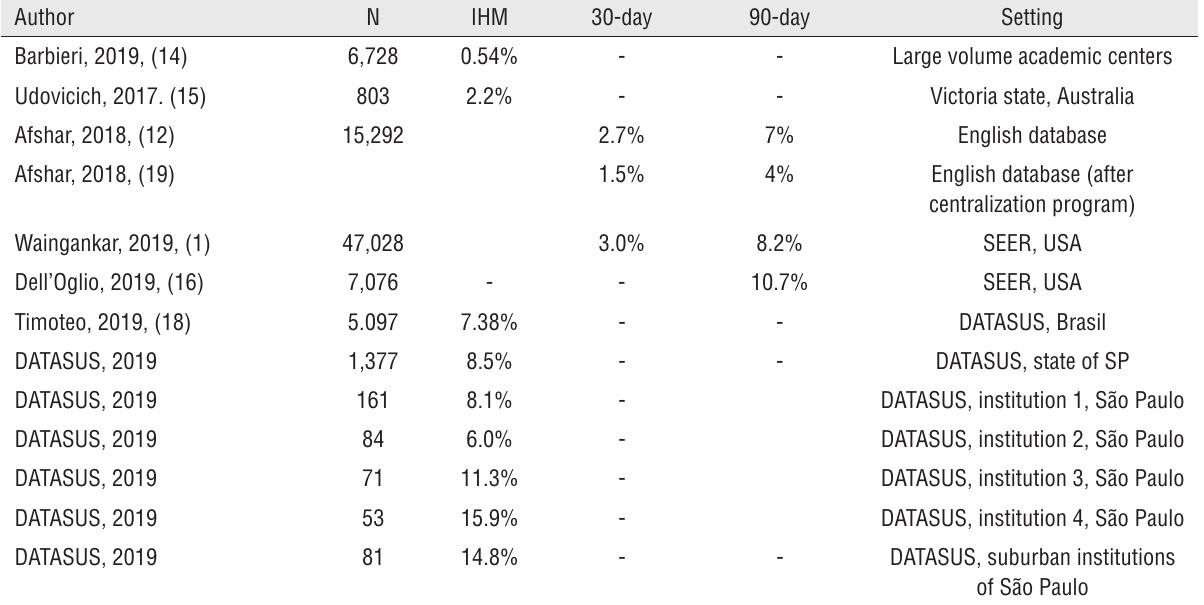
Table 1 - Mortality after radical cystectomy in distinctive